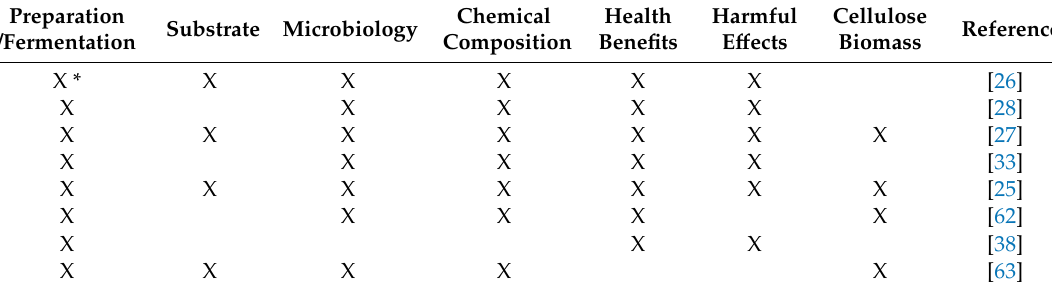
Table 8. Topics covered by comprehensive review papers on